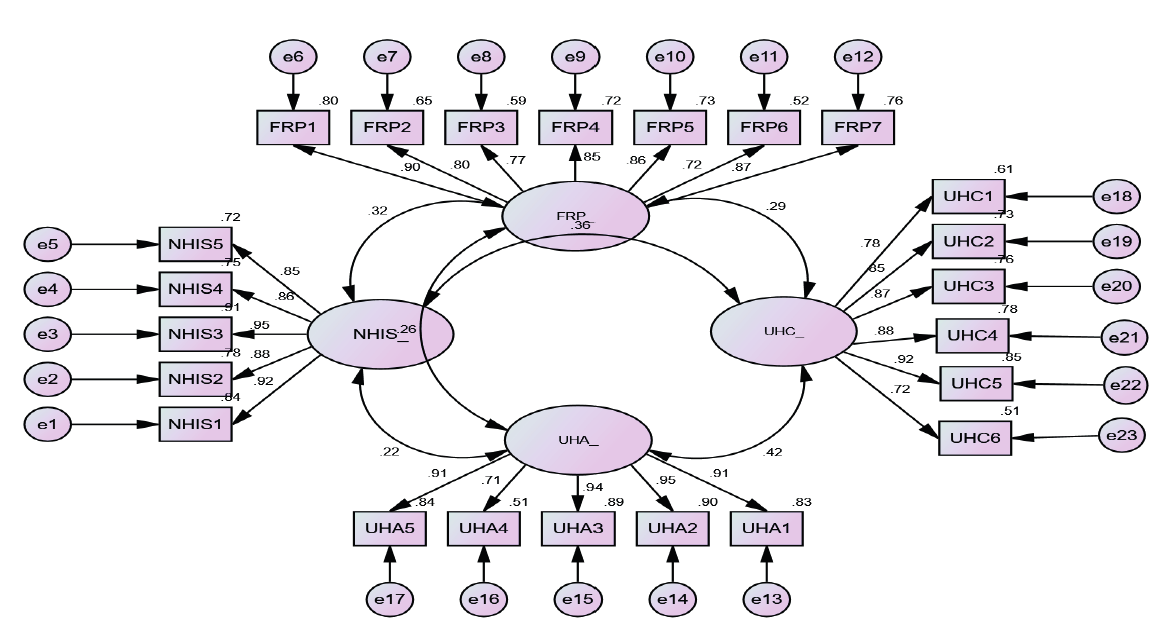
Figure 1. Construct Validity Analysis: Confirmatory Factor Analysis using